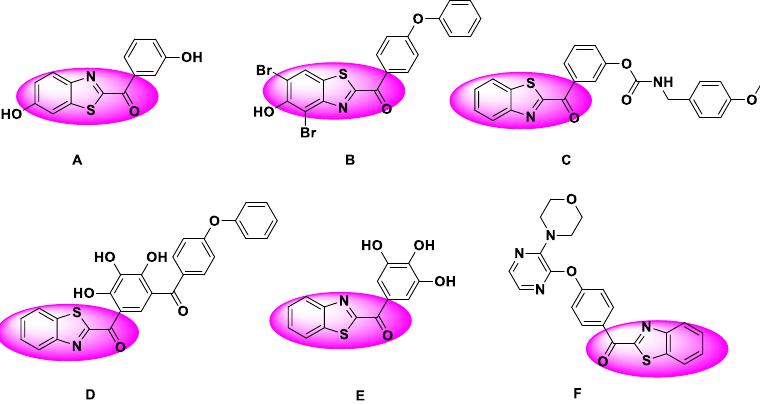
Figure 1. Several C2-arylacylated benzothiazole derivatives with potential as drug candidates.